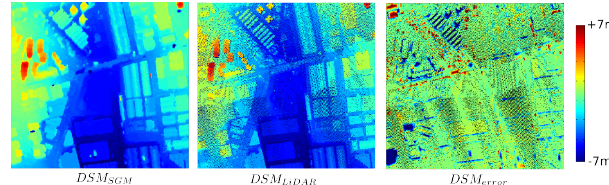
Figure 5: Evaluation of a sample area using the described ap-